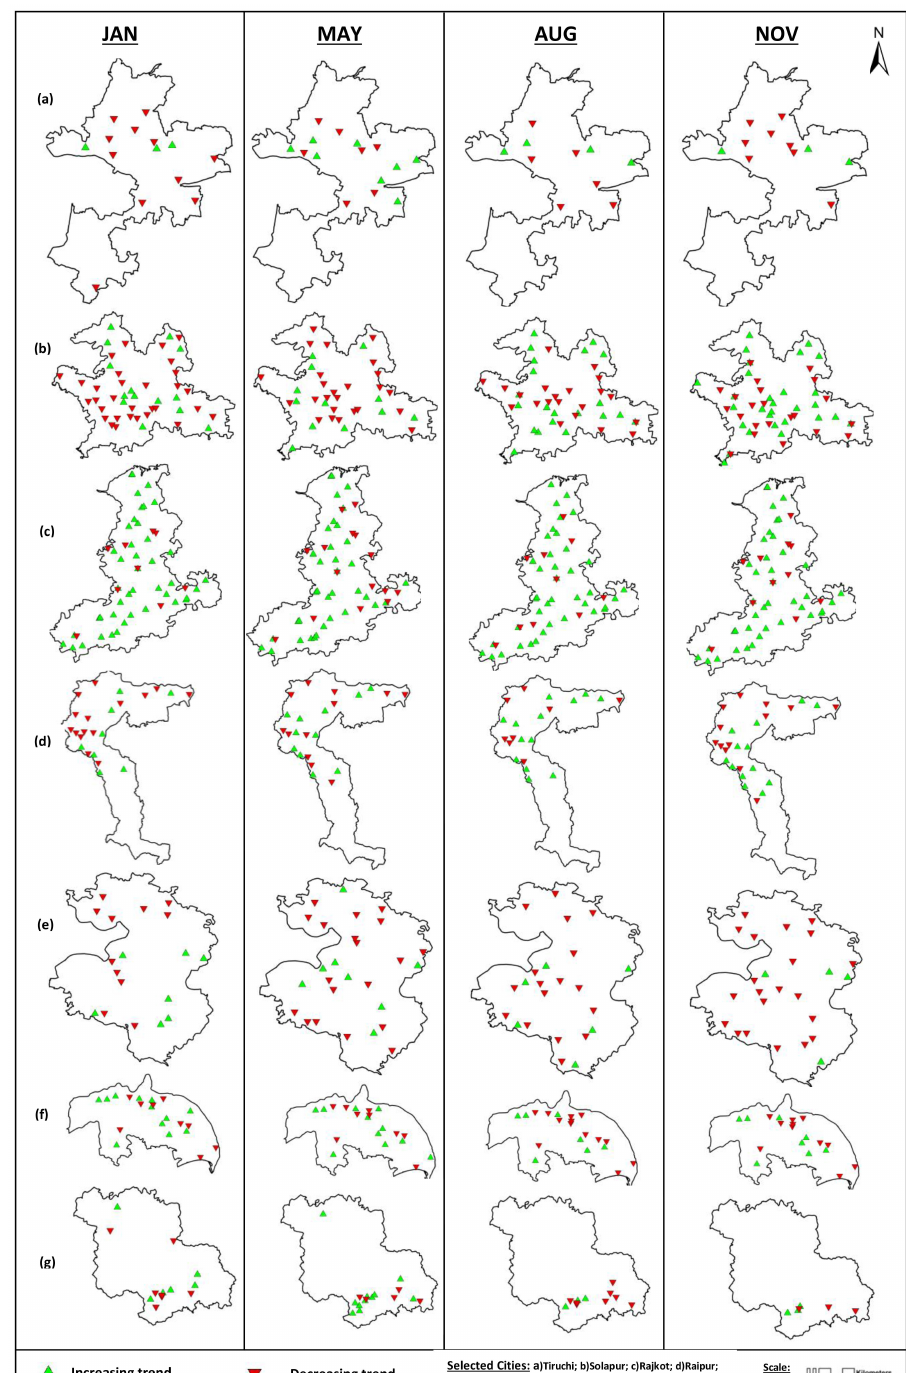
Figure 3. Spatial map depicting GWL trends for individual wells in seven cities during January, May, August, and